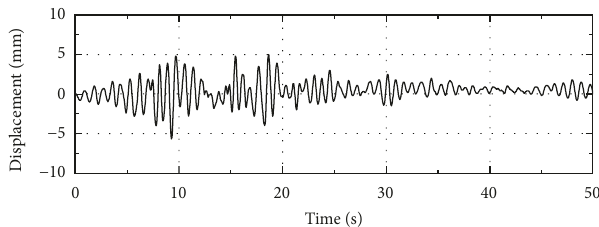
Figure 13: Displacement response curve of intensity 7 frequently of synthesized (longitudinal input).